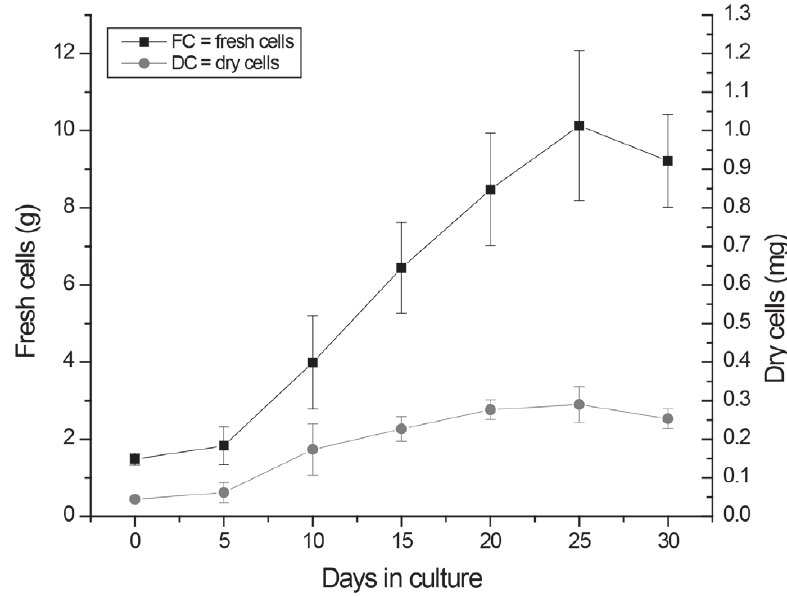
Figure 2 - Curve of calli growth of Boerhavia paniculat a Rich in ½ MS medium supplemented with 1.5% glucose (w/v), 2.265μM of 2,4-D (w/v) and 10% coconut water (v/v). Fresh weight (FW) and dry weight (DW) measured during 35 days by sacrifice sampling.